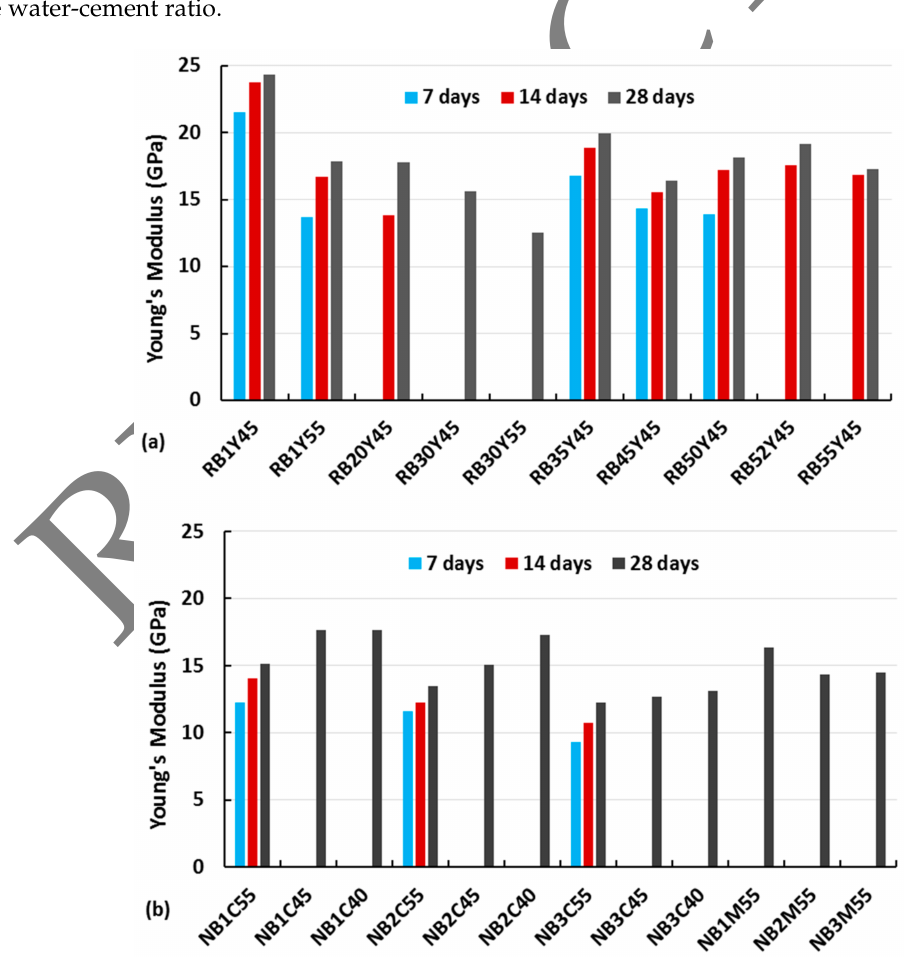
Figure 6. Young’s modulus of ( a ) recycled brick concrete and ( b ) normal brick concrete at different